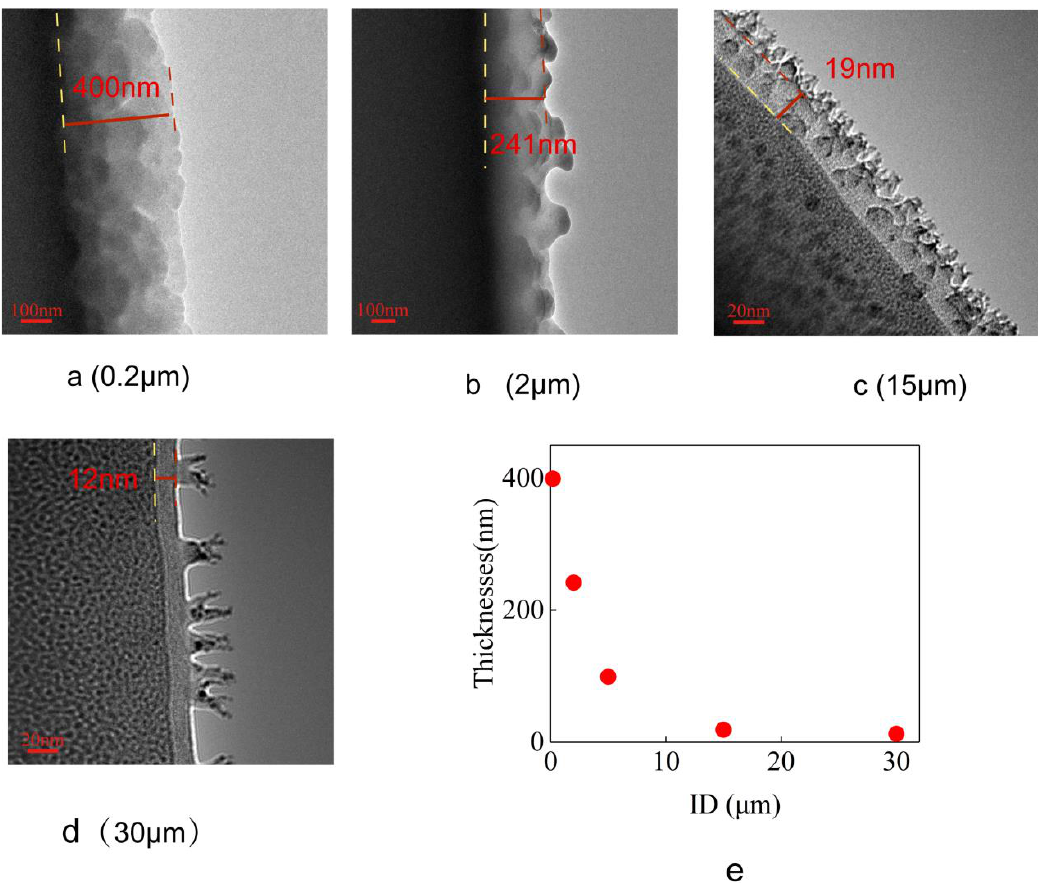
Figure 3. Sectional TEM image of samples in silica microtubules 0. 2 μm, 2 μm, 15 μm and 30 μm in ID and the relationship between thickness of the wall-bound hexadecane layer and the microtubular ID. ( a - d ) Cross-sectional TEM images of samples with microtubule 0.2 μ m, 2 μ m, 15 μ m and 30 μ